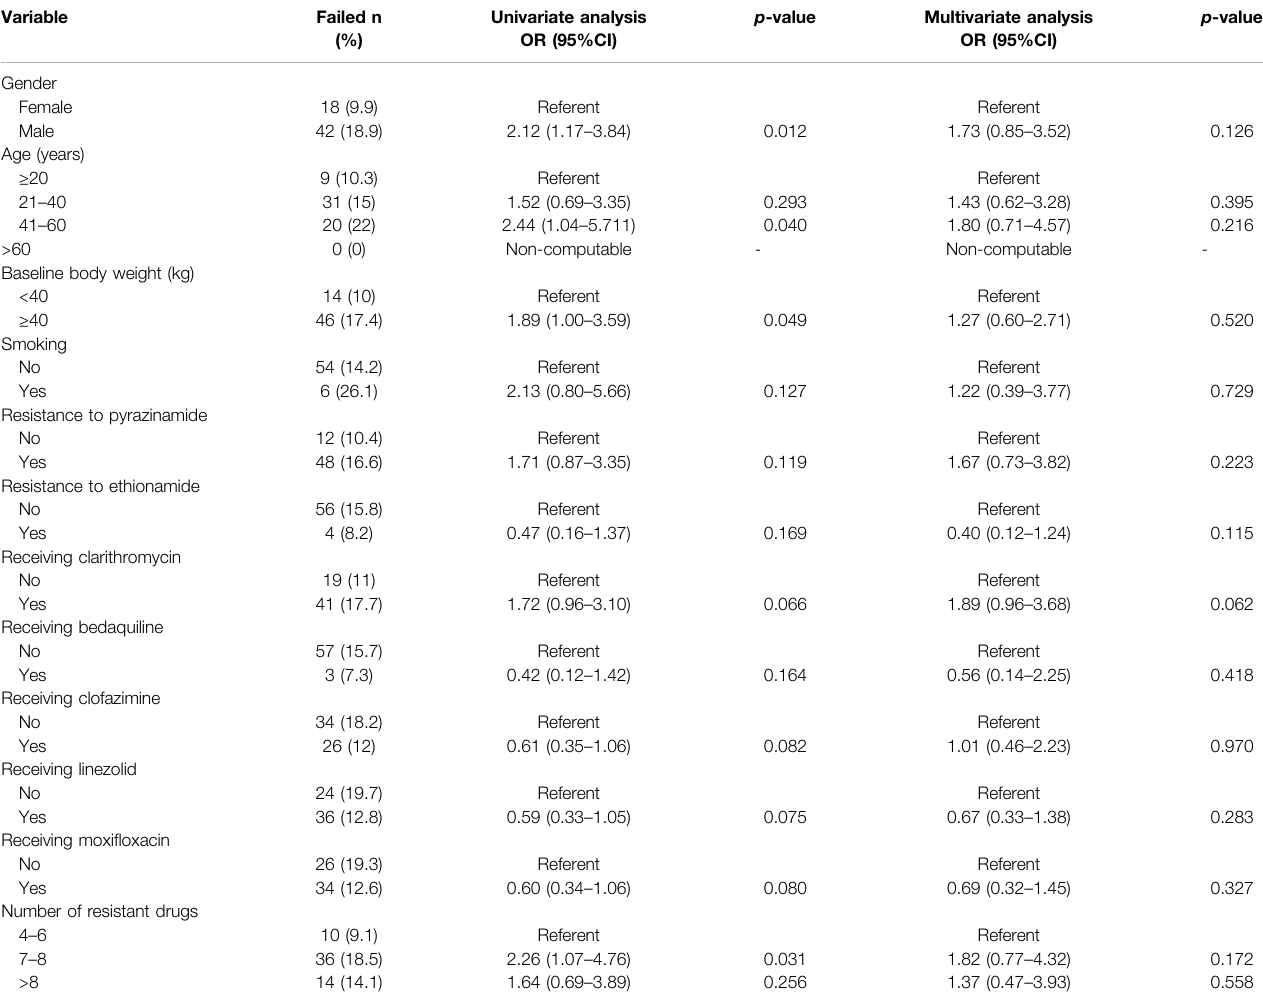
TABLE 5 | Factors associated with treatment